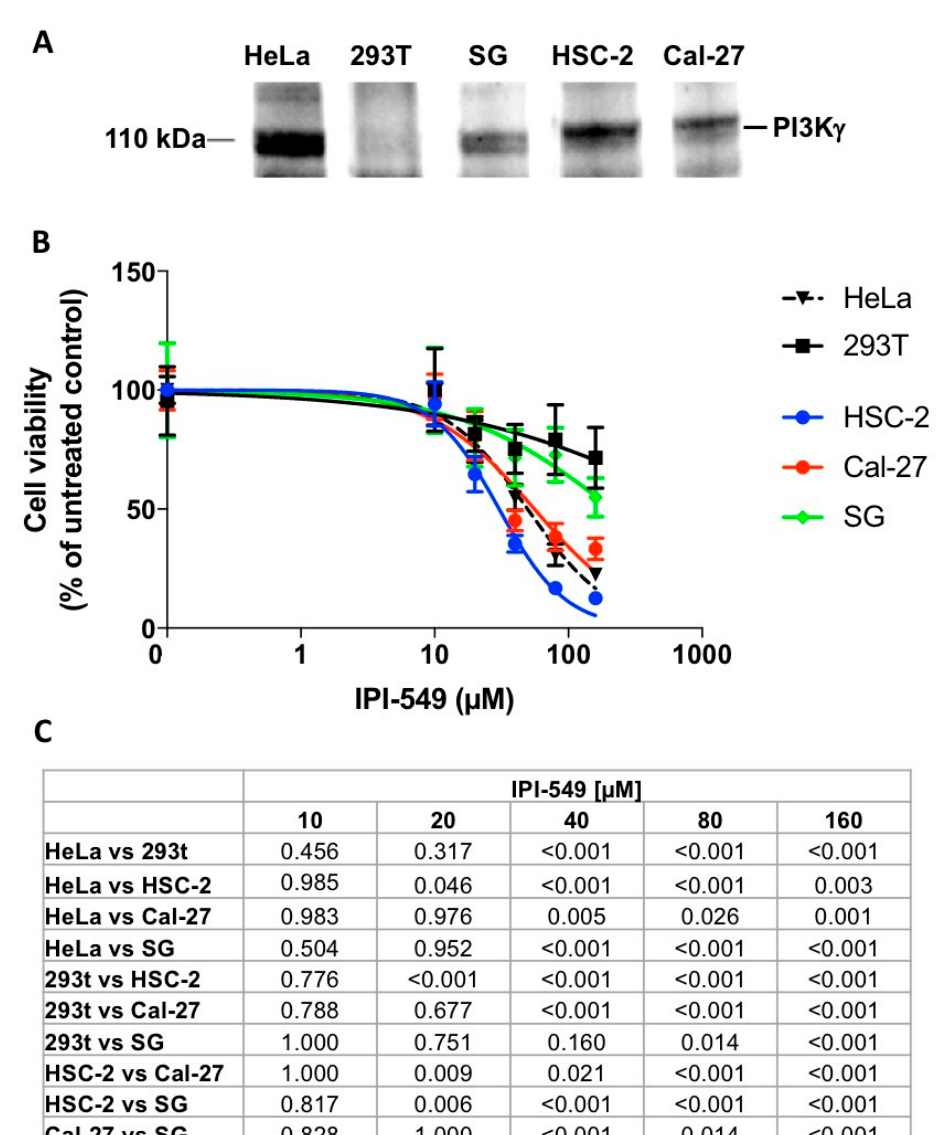
Figure 4. ( A ) Western blot analysis of PI3K γ expression in HeLa, 293T, SG, HSC-2 and Cal-27 whole cell lysates. HeLa and 293T represent, respectively, the positive and the negative control for PI3K γ expression. ( B ) Residual cell vitality in presence of the PI3K γ specific inhibitor IPI-549 (0–160 µ M) as detected by MTT assay. Values, expressed as a percentage of controls, represent mean ± standard error (SEM), p are detailed in ( C ).